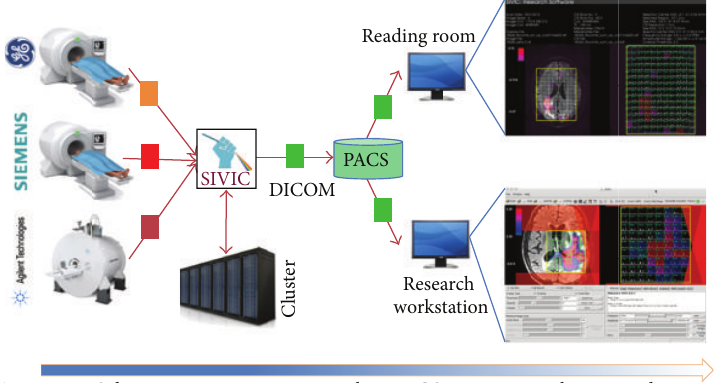
Figure 4: Generalized DICOM MRSI workflow. MRS data is acquired and encoded in vendor specific formats (red, orange, and pink). SIVIC tools reconstruct data and/or convert to DICOM format (green) to send to PACS. DICOM data can be retrieved for visualization in the reading room or on a research workstation for processing and visualization using the SIVIC GUI or command line tools.